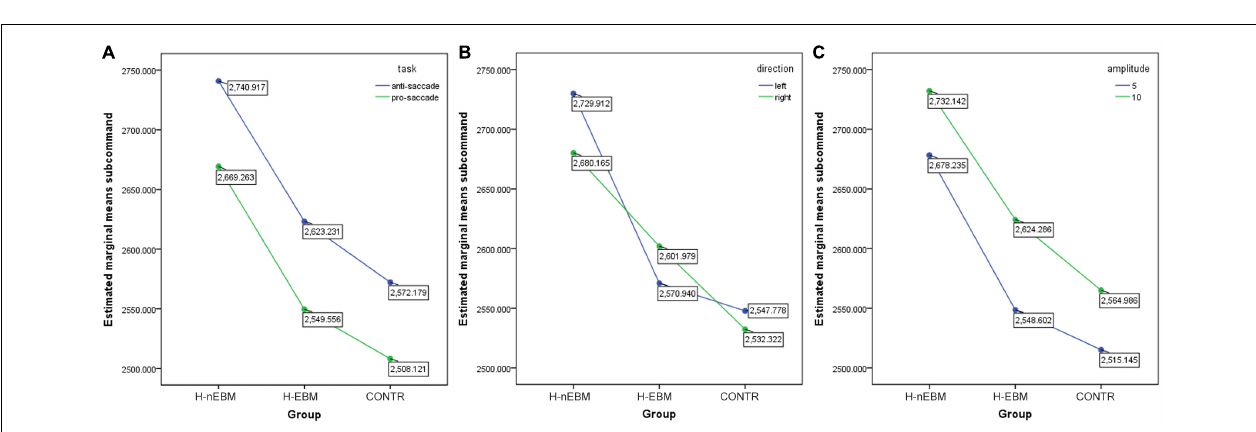
FIGURE 6 | Differences in reaction times in anti-saccade task between H-EBM, H-nEBM, and CONTR groups in (A) pro-saccade and anti-saccade trials; (B) left and right directions; (C) 5 cm and 10 cm